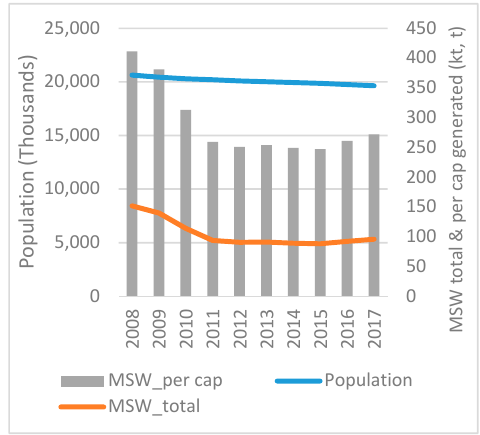
Figure 45. Population and MSW production in Romania 2008–2017 (EUROSTAT 2019a, 2019c).